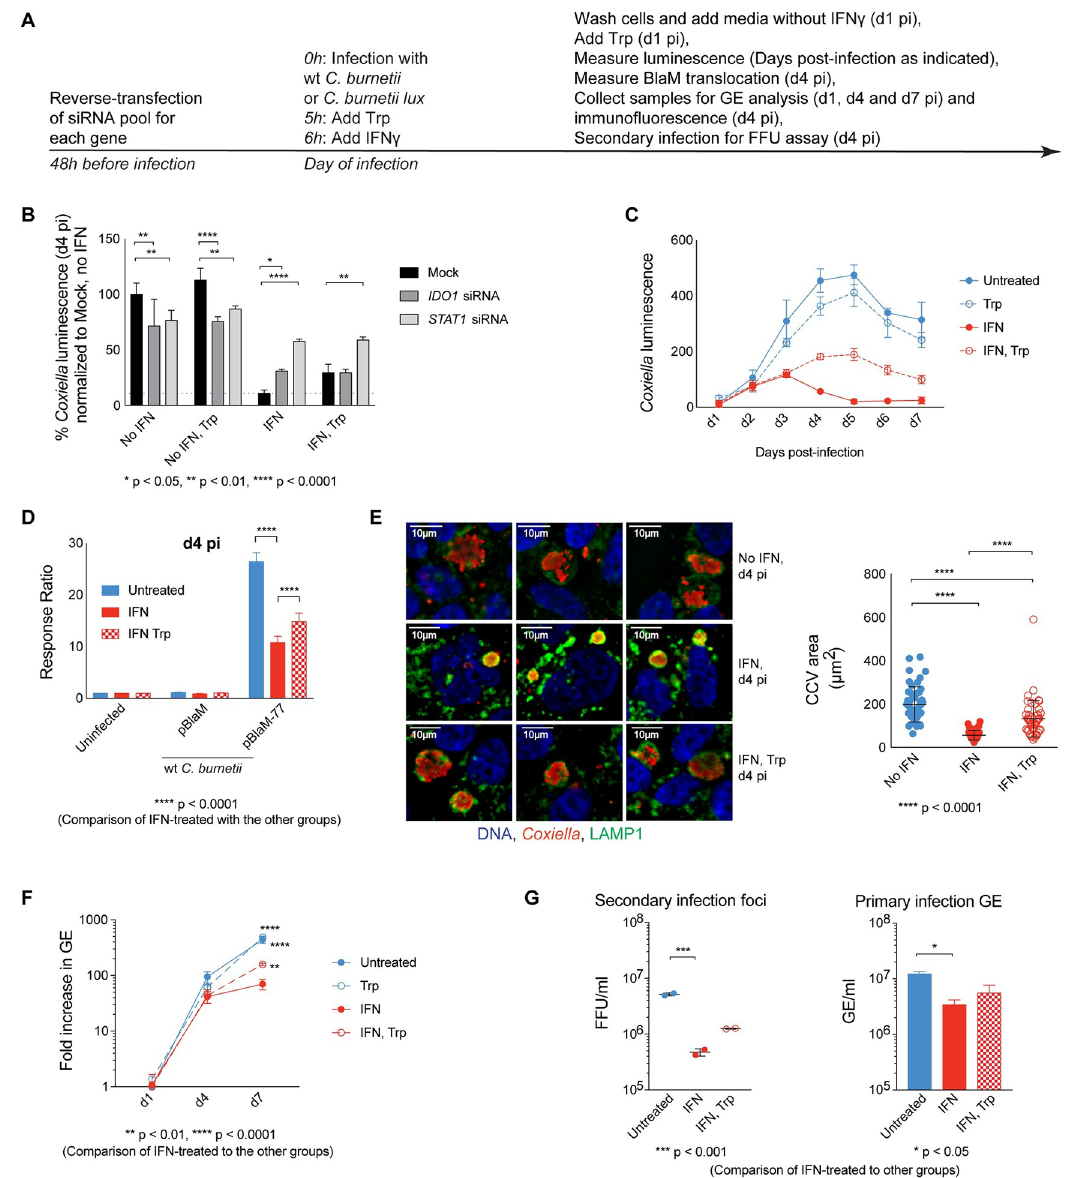
Fig 4. Tryptophan depletion is the mechanism of IDO1-mediated inhibition of C . burnetii replication. Experimental setup is laid out in A. Knocking down IDO1 by siRNA (B) or supplementing the media with tryptophan (B and C) allows replication of C . burnetii lux in IFN γ -treated cells as measured by luminescence. HeLa cells were infected with wt C . burnetii pBlaM or pBlaM-77 and left untreated or treated with IFN γ in the presence or absence of additional tryptophan. On d4 pi, cells were loaded with the fluorescent substrate CCF4-AM and translocation of BlaM was assessed by the shift in the fluorescence emission from 535 to 460nm relative to that of uninfected (D). CCV were visualized by indirect immunofluorescence on d4 pi and average CCV sizes were quantified for about 40–50 CCVs per experimental condition (E). Fold increase in GE on d4 and d7 pi, compared to that of d1 pi were measured by qPCR (F). FFU/ml of bacteria derived from HeLa cells infected with C . burnetii in the presence or absence of IFN γ and Trp were determined by secondary infection of HeLa cells (G, left panel). As a control, GE was measured after primary infection (G, right panel).